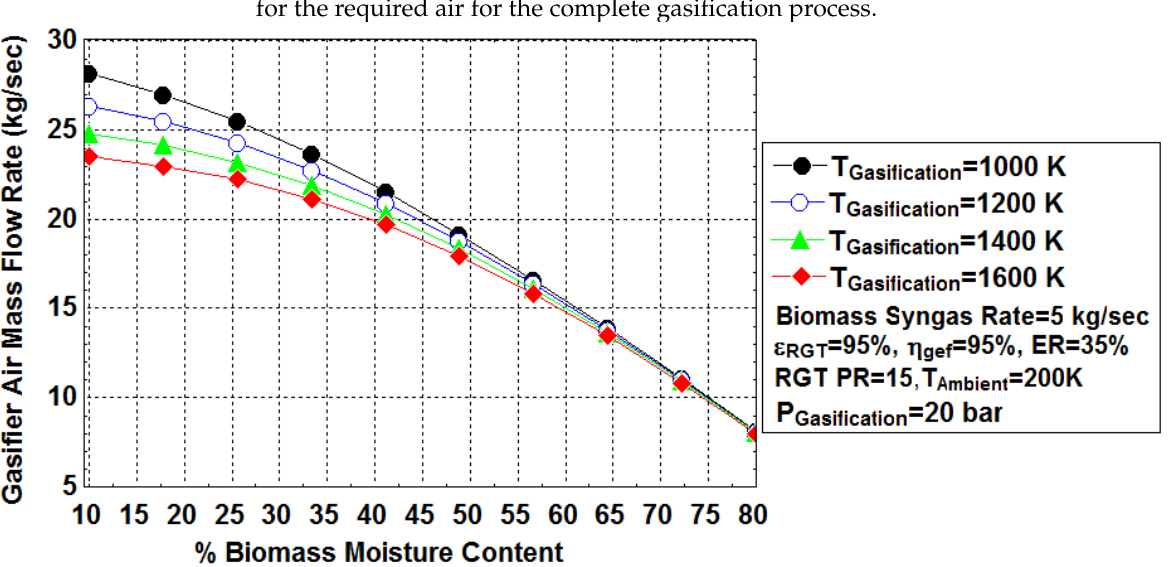
Figure 7. Effect of biomass moisture content on the gasifier’s airflow rate at different gasification temperatures.